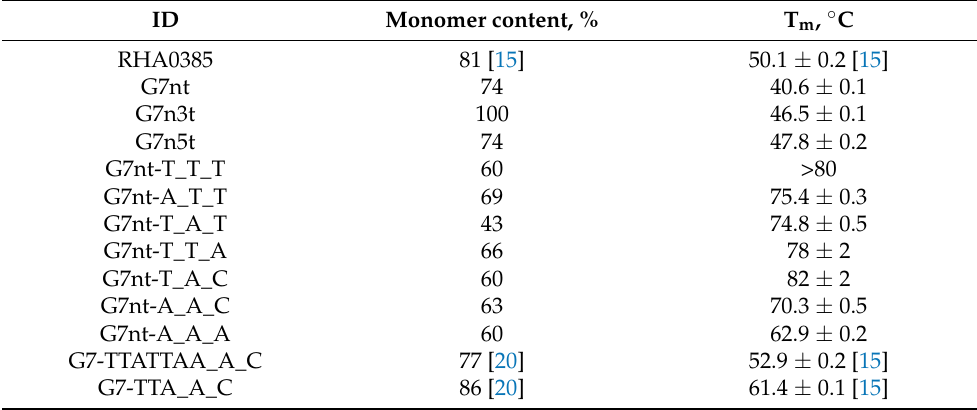
Table 3. Content of intramolecular G-quadruplexes according to SE-HPLC and melting temperature of G-quadruplexes (T m